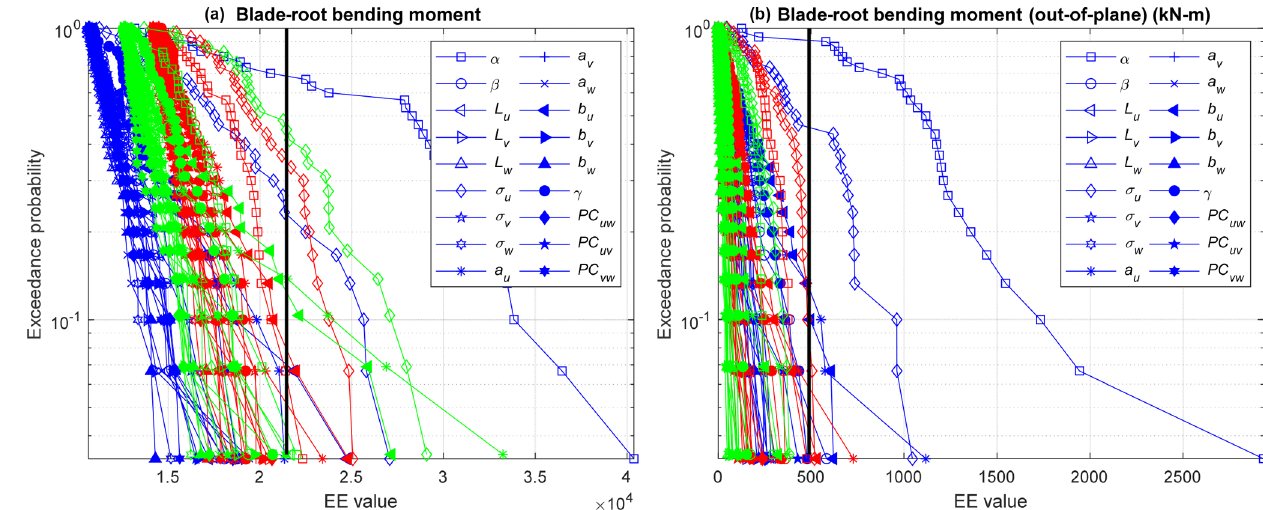
Figure 6. Exceedance probability plot of ultimate (a) and fatigue (b) load EE values for blade-root bending moments. Each line represents a different input parameter and wind speed bin (blue is below-rated speed, red is near-rated speed, green is above-rated